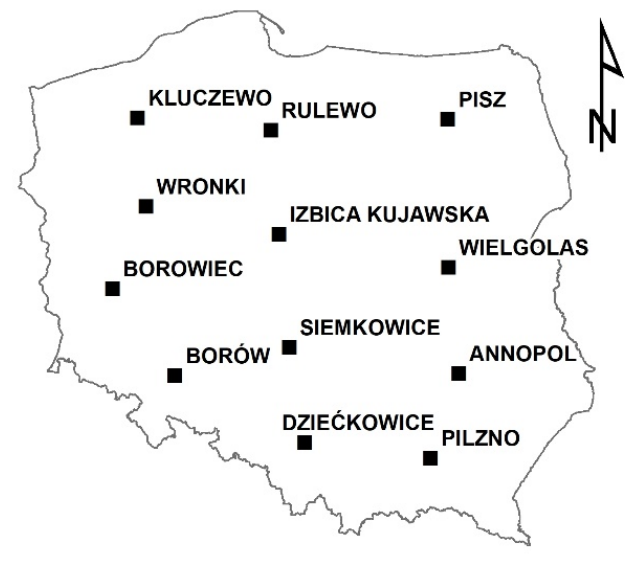
Figure 4. Location of control stations.